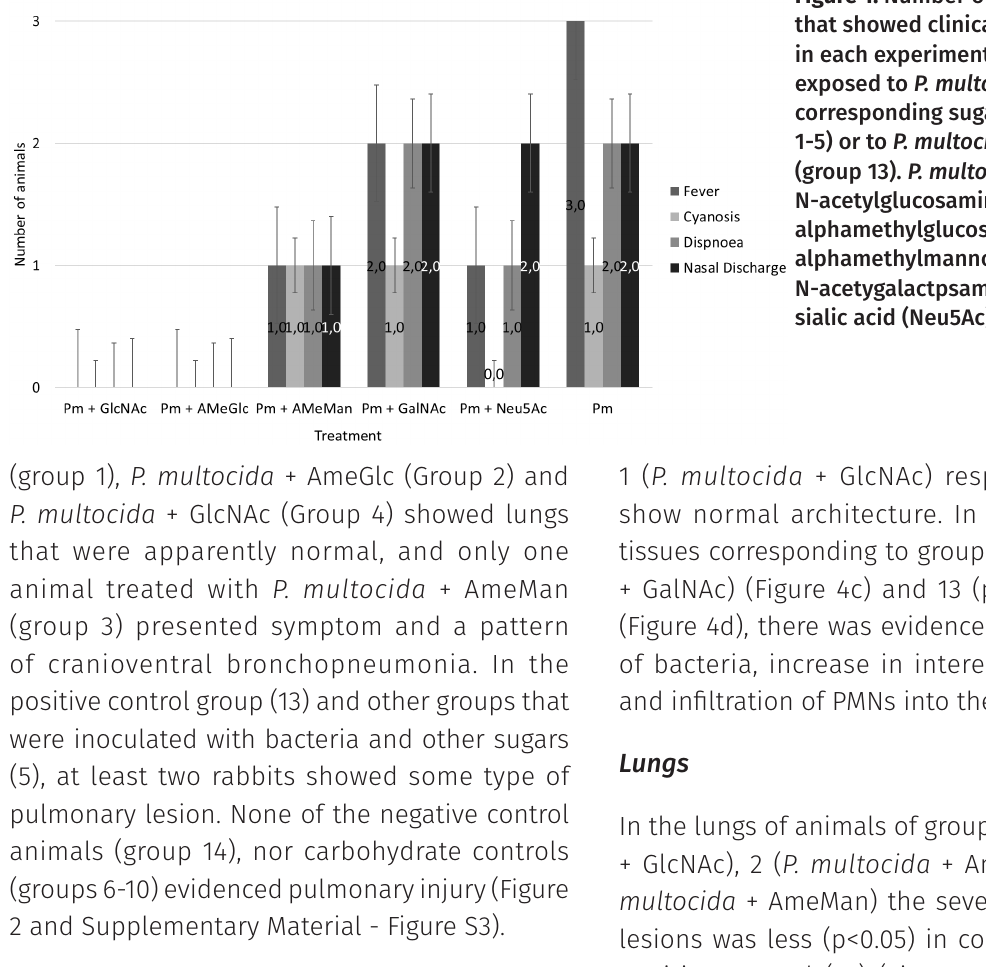
Figure 1. Number of rabbits that showed clinical signs in each experimental group exposed to P. multocida with the corresponding sugars (groups 1-5) or to P. multocida alone (group 13). P. multocida (Pm) , N-acetylglucosamine (GIcNAc), alphamethylglucoside (AMeGIc), alphamethylmannoside (AMeMan) , N-acetygalactpsamine (GaINAc) or sialic acid